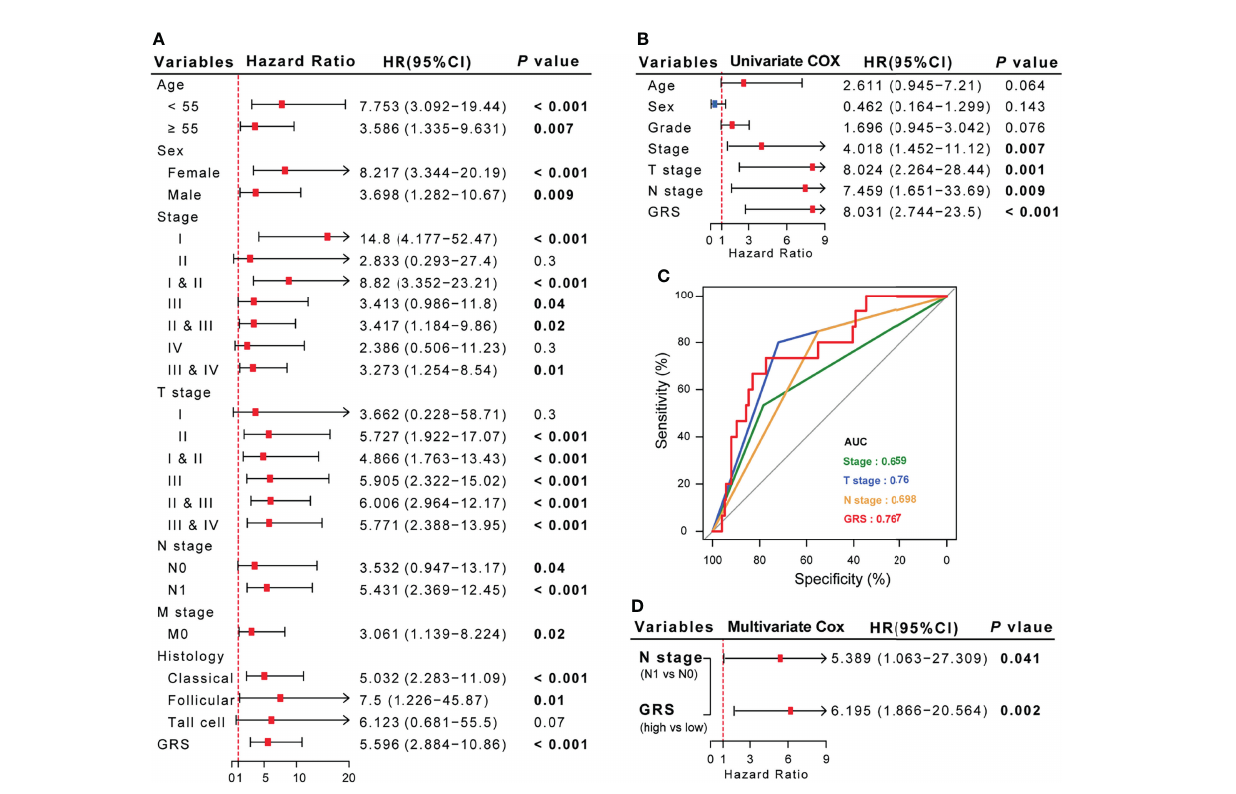
FIGURE 7 | The comprehensive risk factor database for recurrence in DTC patients was established based on GRS and traditional features. (A, B) Univariate Cox regression analysis of the association between clinicopathological features, GRS and RFS. (C) Comparison of the diagnostic ef fi cacy of GRS with traditional clinical indices via ROC curve analysis. (D) Multivariate Cox regression analysis demonstrated that N stage and GRS are independent risk factors for RFS in DTC